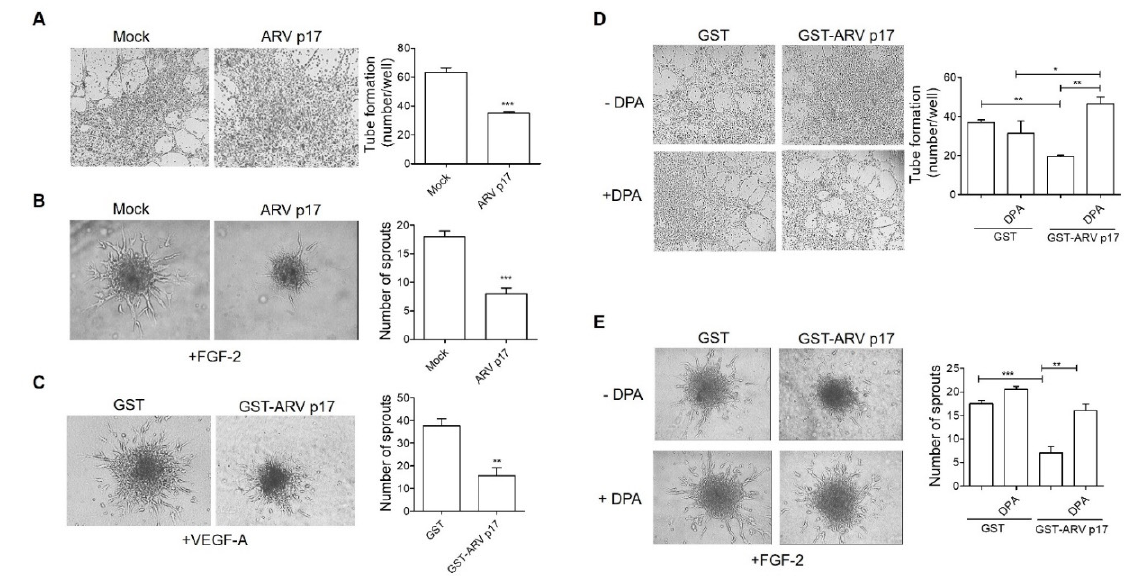
Figure 8. Effect of ARV p17 expression on Human Microvascular Endothelial Cells (HMVECs) angiogenesis. HMVEC cells were mock-nucleofected (Mock) or nucleofected with ARV p17-expressing plasmid (ARV p17). Angiogenesis was analyzed 48 h post-nucleofection ( A , B ). ( A ) HMVECs were seeded on BME-coated plates. Images were taken after 6 h of HUVEC culture on BME (original magnification, 4 × ). Closed rings were counted as a parameter for quantification of tube formation. Values are the mean ± SD of one representative experiment out of two with similar results, performed in triplicates. Statistical analysis was performed by Student’s t test. *** p < 0.001. ( B ) Sprouting of spheroids generated by Mock or ARV p17 HMVECs upon FGF-2 treatment. Pictures were taken after 24 h of culture (original magnification, 20 × ). The bar graph shows the average number/spheroid of EC sprouts. Values are the mean ± SD of one representative experiment out of two with similar results, performed in triplicates. Statistical analysis was performed by Student’s t test. *** p < 0.001. HMVECs were pretreated with 10 ng/mL of either recombinant GST or GST-ARV p17 for 24 h ( C – E ). ( C ) Spheroid assay in the presence of Vascular Endothelial Growth Factor A (VEGF-A) (30 ng/mL) to assess sprout formation after 24 h in GST- and GST-ARV p17-pretreated cells (original magnification, 10 × ). The bar graph shows the average number/spheroid of EC sprouts. Values are the mean ± SD of one representative experiment out of two with similar results, performed in triplicates. Statistical analysis was performed by Student’s t test. ** p < 0.01. ( D ) Tube formation assay in the presence of DPA (10 µ M) to assess capillary-like structures in GST- and GST-ARV p17-pretreated cells. Pictures were taken after 8 h of culture (original magnification, 4 × ). Closed rings were counted as a parameter for quantification of tube formation. Values are the mean ± SD of one representative experiment out of two with similar results, performed in triplicates. Statistical analysis was performed by one-way ANOVA and Bonferroni’s post-test was used to compare data. * p < 0.05; ** p < 0.01. ( E ) Spheroid assay in the presence of DPA (10 µ M) and FGF-2 (100 ng/mL) to assess sprout formation after 24 h in GST- and GST-ARV p17-pretreated cells (original magnification, 20 × ). The bar graph shows the average number/spheroid of EC sprouts. Pictures are representative of one out of two independent experiments with similar results. Values are the mean ± SD of one representative experiment out of two with similar results, performed in triplicates. Statistical analysis was performed by one-way ANOVA and Bonferroni’s post-test was used to compare data. ** p < 0.01; *** p <